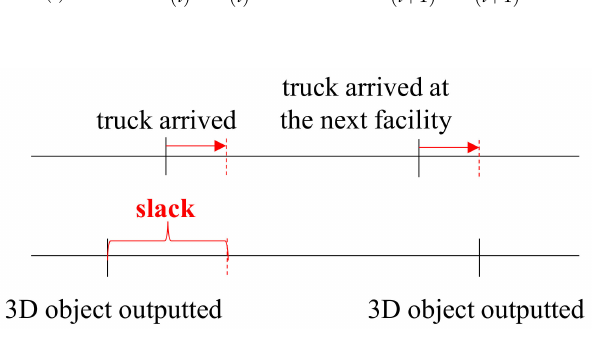
Figure 4. Determining the slack.